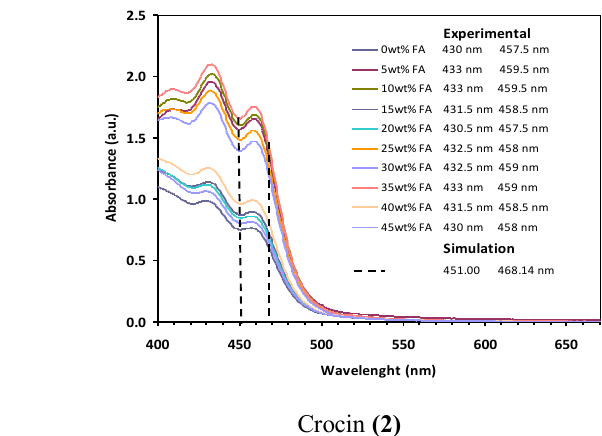
Table 1: Some selected components of the static